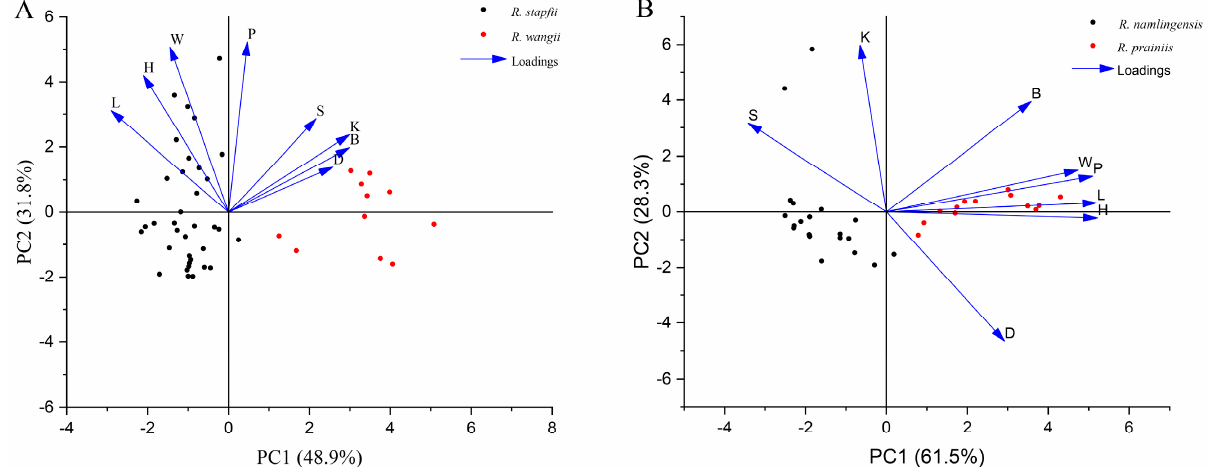
Figure 1. Principal component analysis based on the leaf traits. ( A ) Lhünz ê population and Rhodiola stapfii (Raymond-Hamet) S.H. Fu. ( B ) R. namlingensis S.Y. Meng and R. prainii (Hamet) H.